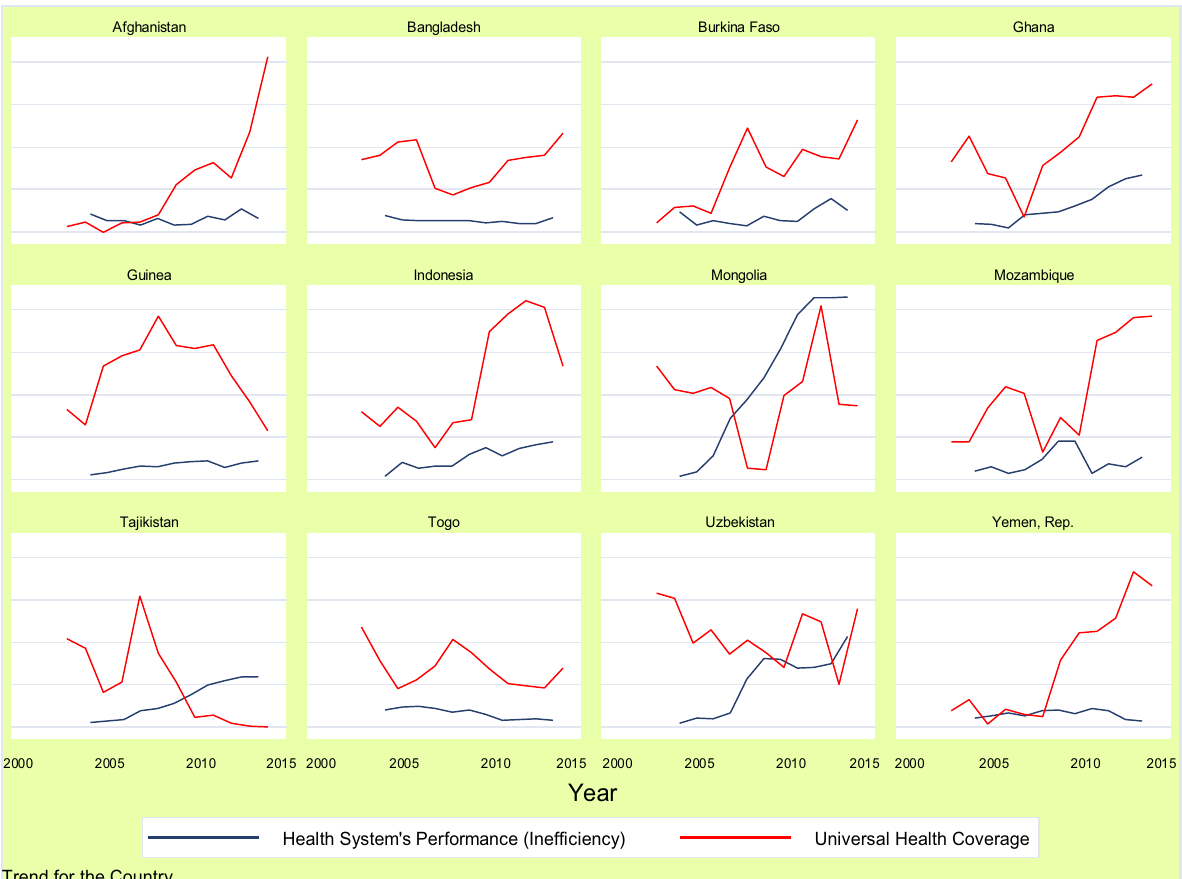
Fig. 1 Cross-dynamics: The health system ’ s performance (inef fi ciency) and the Universal Health